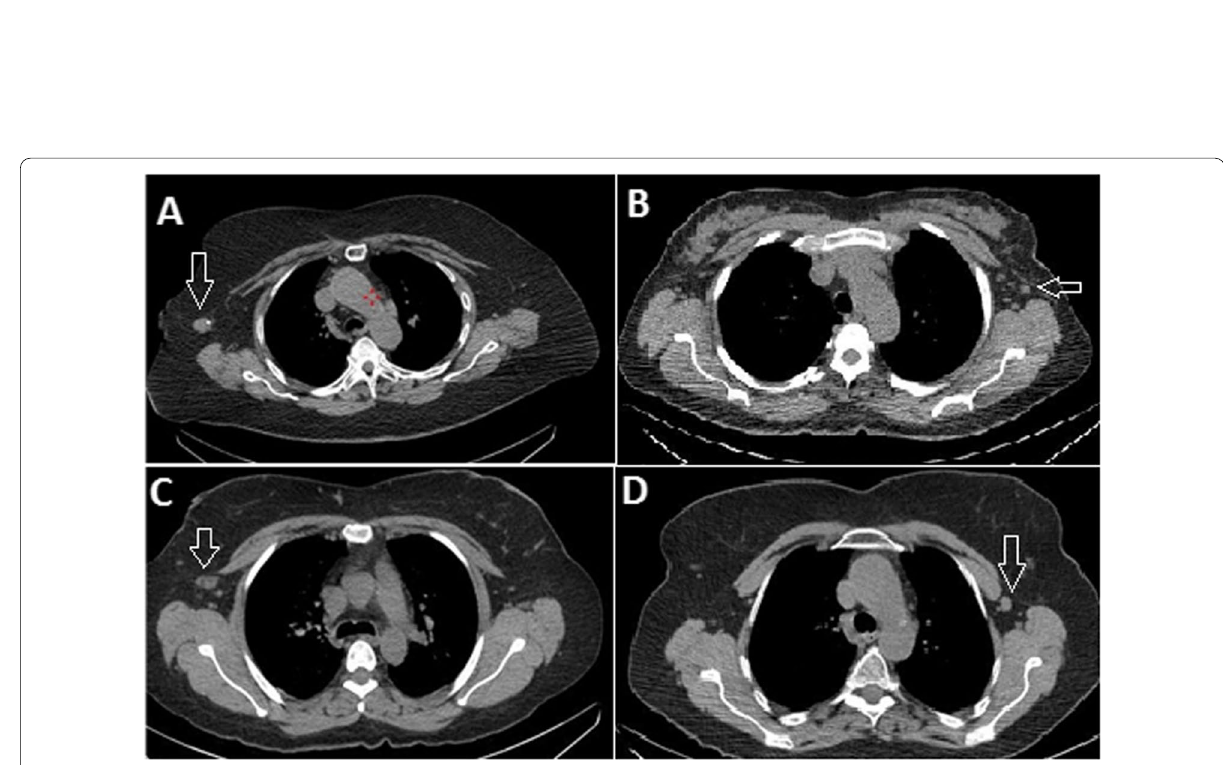
Fig. 5 Characterization of CT features of sentinel lymph nodes detected on SPECT/CT showing A Pleomorphic calcification, B Round, C Enlargement with hilar effacement and loss of hilar fat, D Enlarged with nodal replaced with